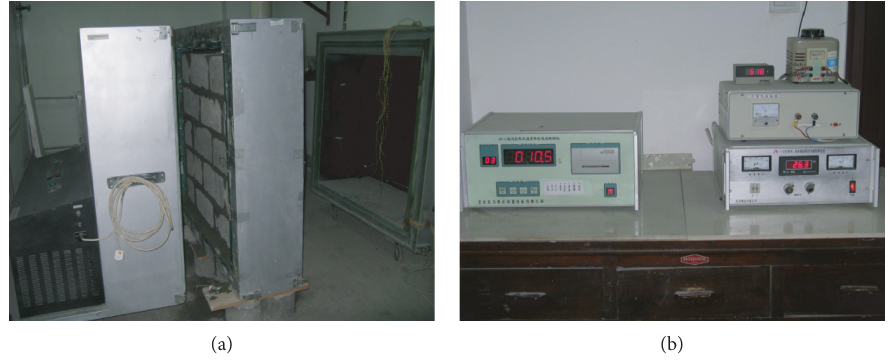
Figure 15: Test instrument. (a) JW-I; (b) JW-II.